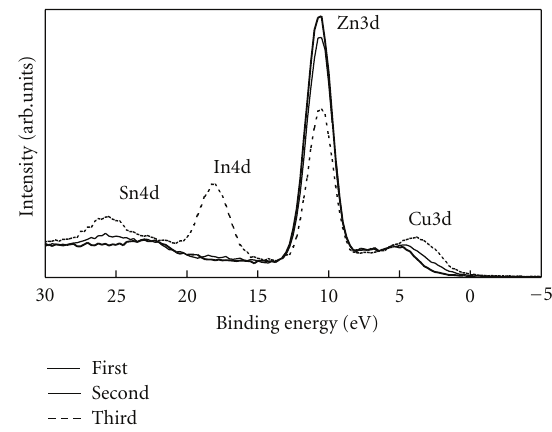
Figure 11: XPS spectra of Sn4d and Zn3d core levels near the ZnO/CTSO interface taken with three di ff erent sputtering